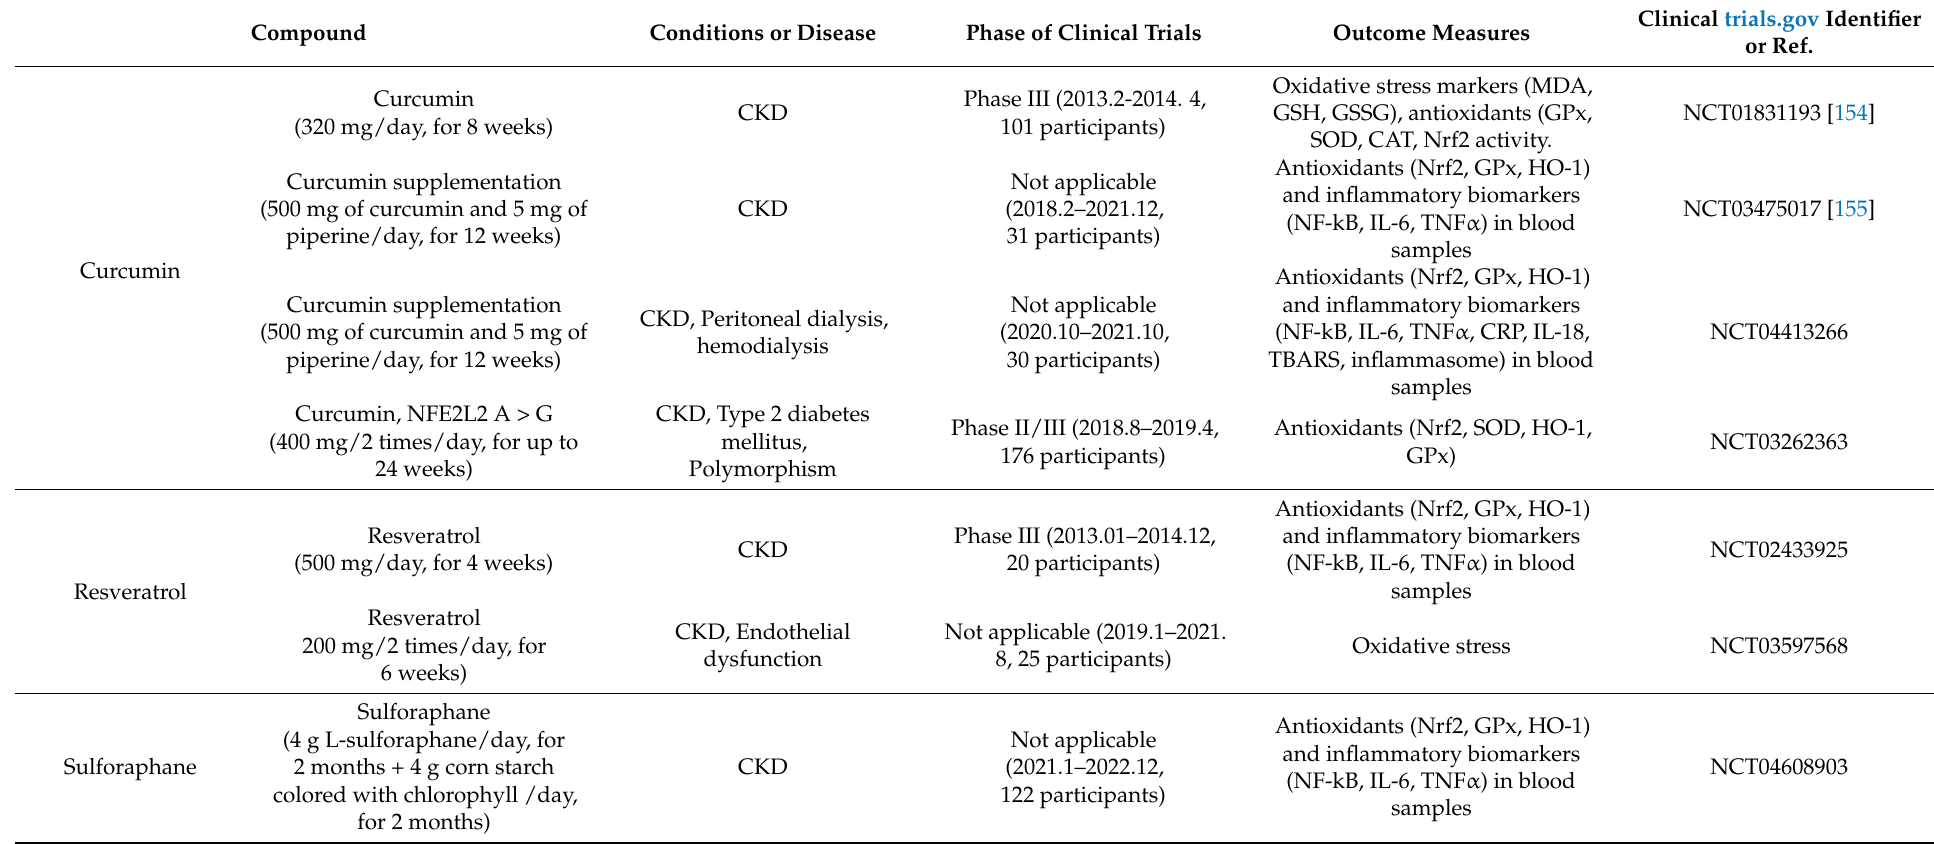
Table 3. Antioxidant natural compounds used for treating CKD